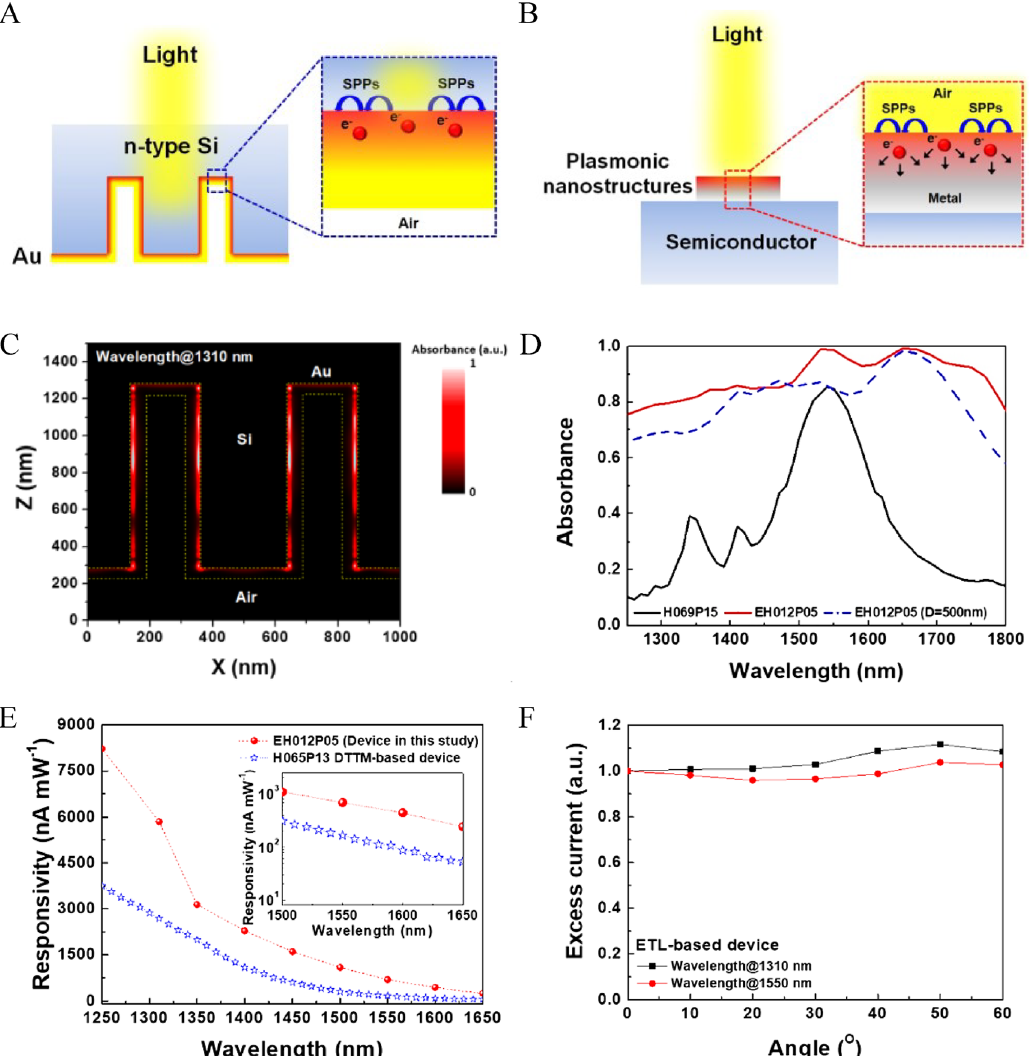
Figure9: Schematicillustrationsoftheoptoelectronicbehaviorsof(A)ETLantenna-baseddeviceand(B)mostofactiveopticalantenna-based devices under IR illumination. (C) Absorption map of the ETL antenna-based device at a wavelength of 1310 nm. (D) Simulated absorbance spectra and (E) measured spectral photoresponsivity of the ETL antenna-based and DTTM antenna-based devices. (F) Measured photoreponses of ETL antenna-based device at different angles of incidence and wavelengths of 1310 (black line) and 1550 nm (red line) [43]. Copyright 2019, American Chemical